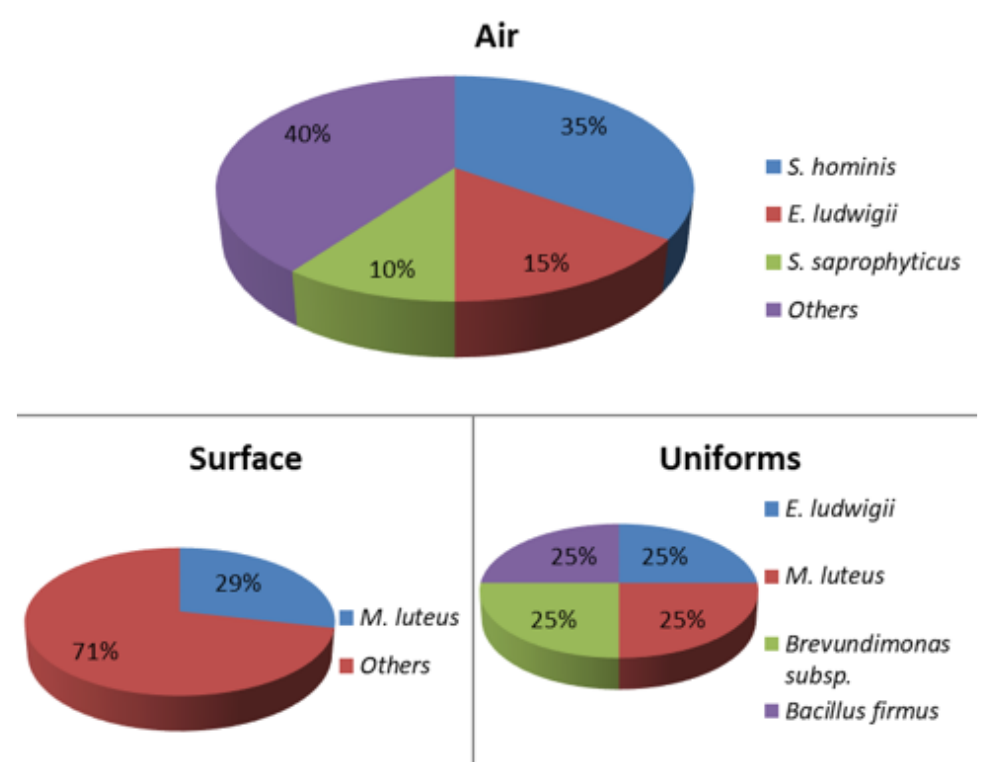
FIGURE 5 – Microorganisms identified in air, surface and uniforms samples of Material and sterilization center (MSC) – Hospital